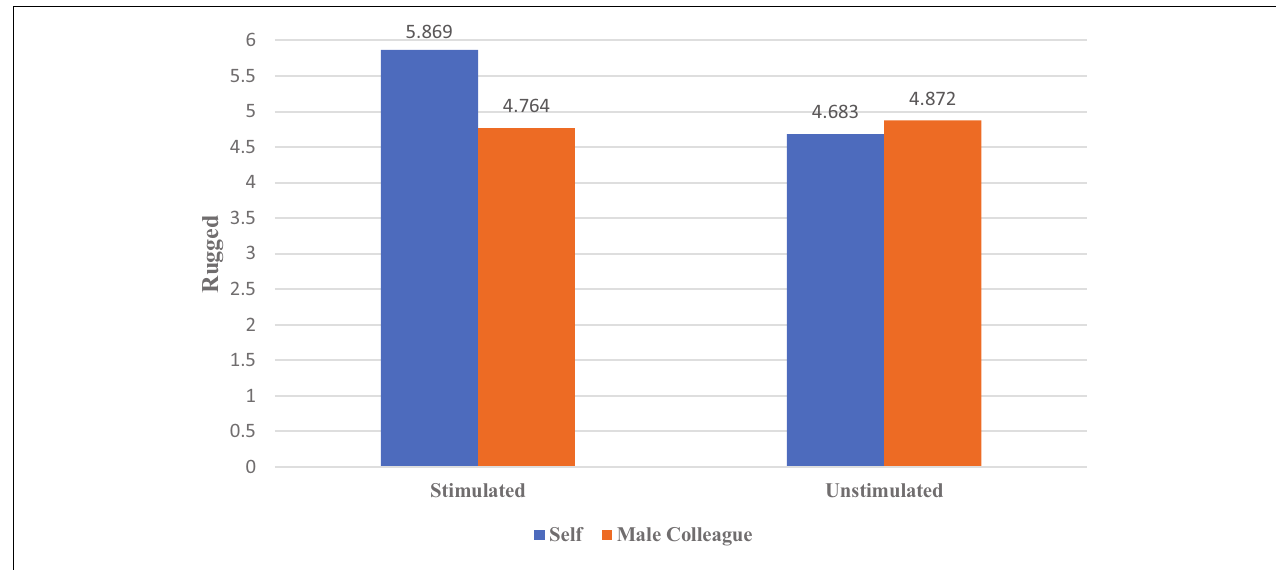
FIGURE 4 | The effect of erotic stimulation on men’s perception of the rugged personality of different owners’ possessions.